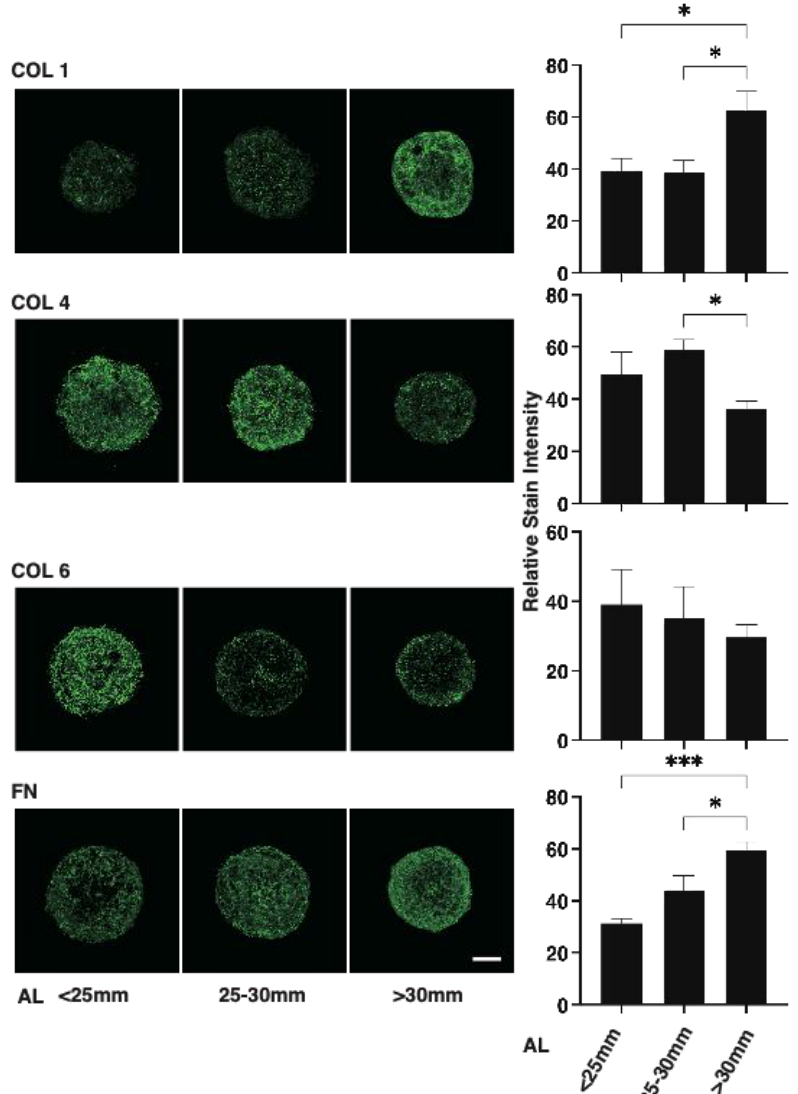
Figure 4. Immunolabeling of ECM in the 3D spheroids of human scleral stroma fibroblasts (HSSFs). The three different ALs <25 mm, 25–30 mm, or >30 mm of 3D spheroids of HSSFs were subjected to immunolabeling of ECM proteins including COL1, COL4, COL6, and FN at Day 5. Representative images and plots of the relative staining intensities for each ECM are shown in panels A and B, respectively. All experiments were performed in duplicate using fresh preparations ( n = 5, each). Data are presented as the arithmetic mean ± standard error of the mean (SEM). * p < 0.05, *** p < 0.005 (ANOVA followed by Tukey’s multiple comparison test).